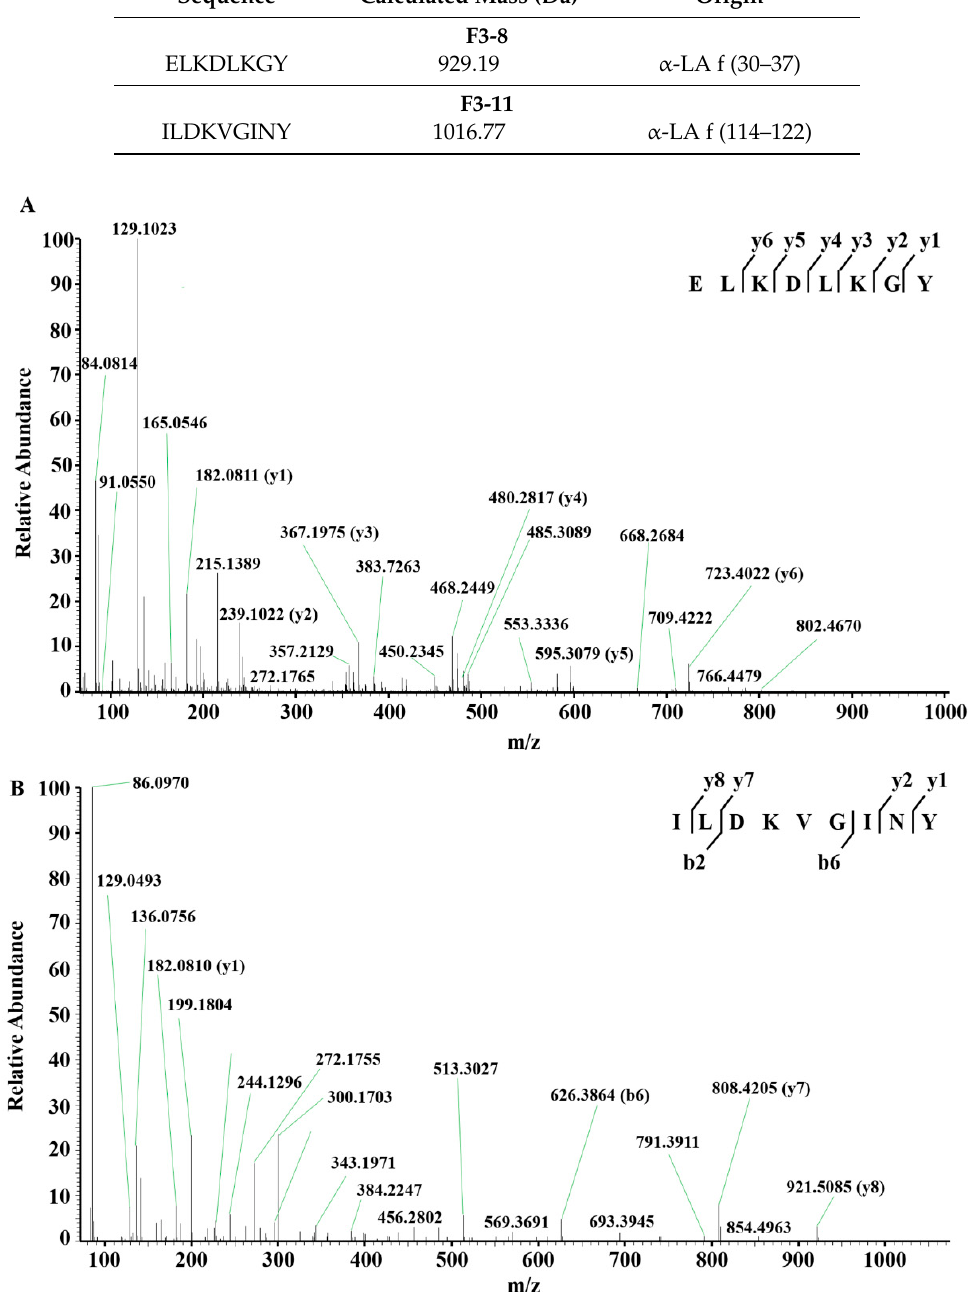
Table 1. Liquid chromatography-electrospray ionization tandem mass spectrometry (MS) identification of dipeptidyl peptidase-IV (DPP-IV) inhibitory peptides in fraction F3-8 and F3-11 obtained by HPLC.